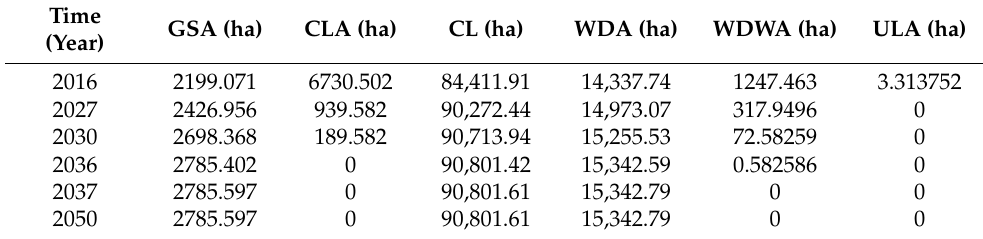
Table 4. Results of the Simulation of Green Space in Beijing’s Central District.